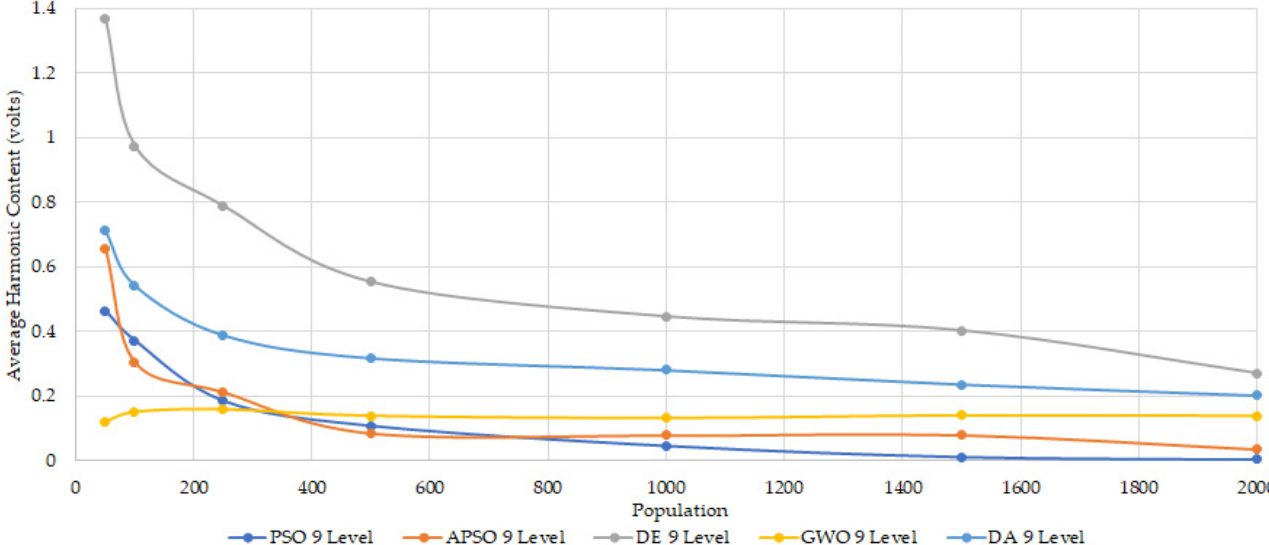
Figure 10. Algorithms’ average performance for a seven-level inverter.